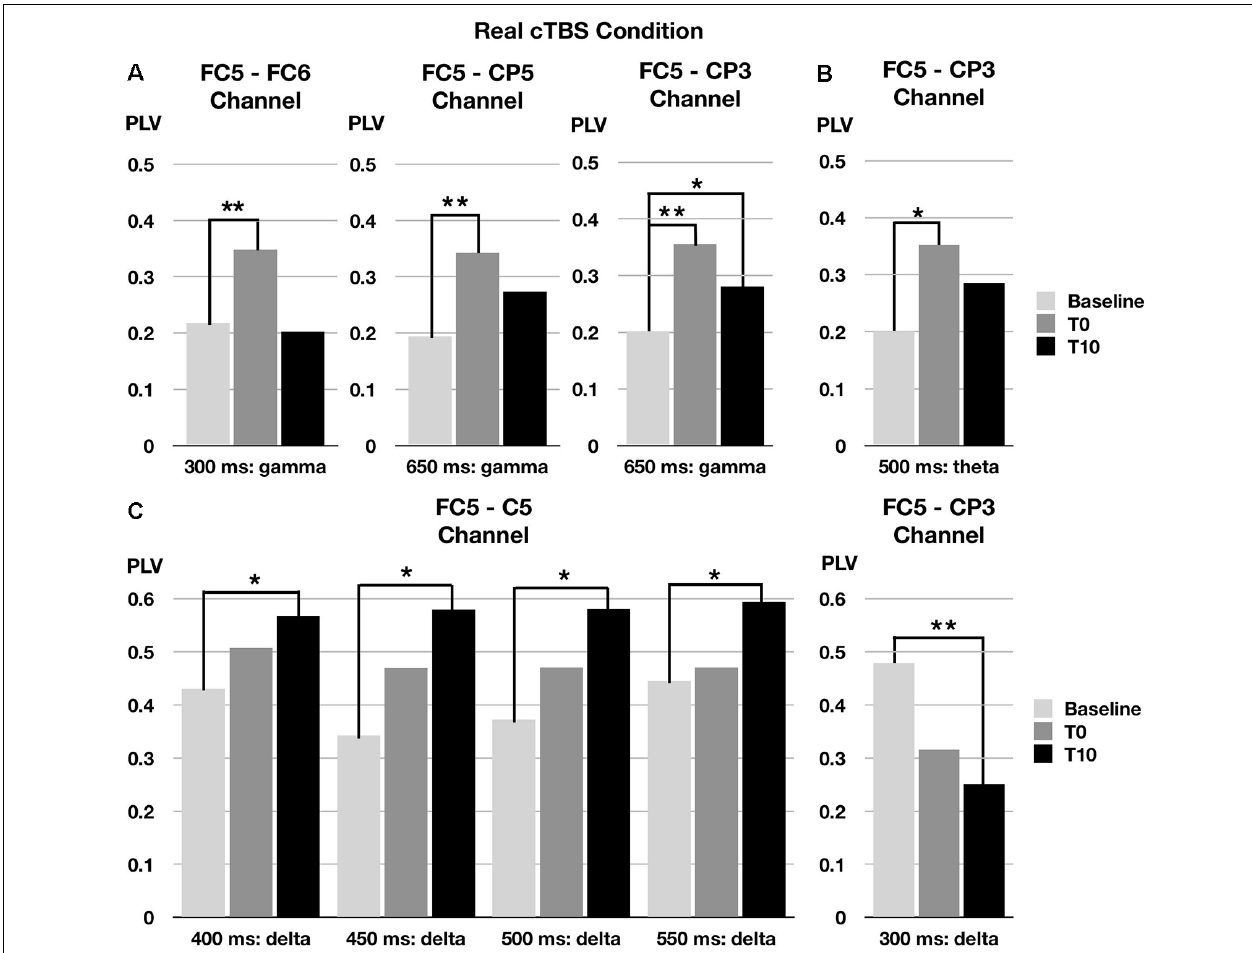
FIGURE 3 | Changes of phase locking value (PLV) by real cTBS on the left pars opercularis. cTBS, continuous theta-burst stimulation. FC5, FC6, CP3, and CP5 correspond to left pars opercularis, right pars opercularis, left supramarginal area, and left superior temporal area, respectively. * p < 0.05, ** p < 0.01. (A) Gamma band changes. (B) Theta band changes. (C) Delta band